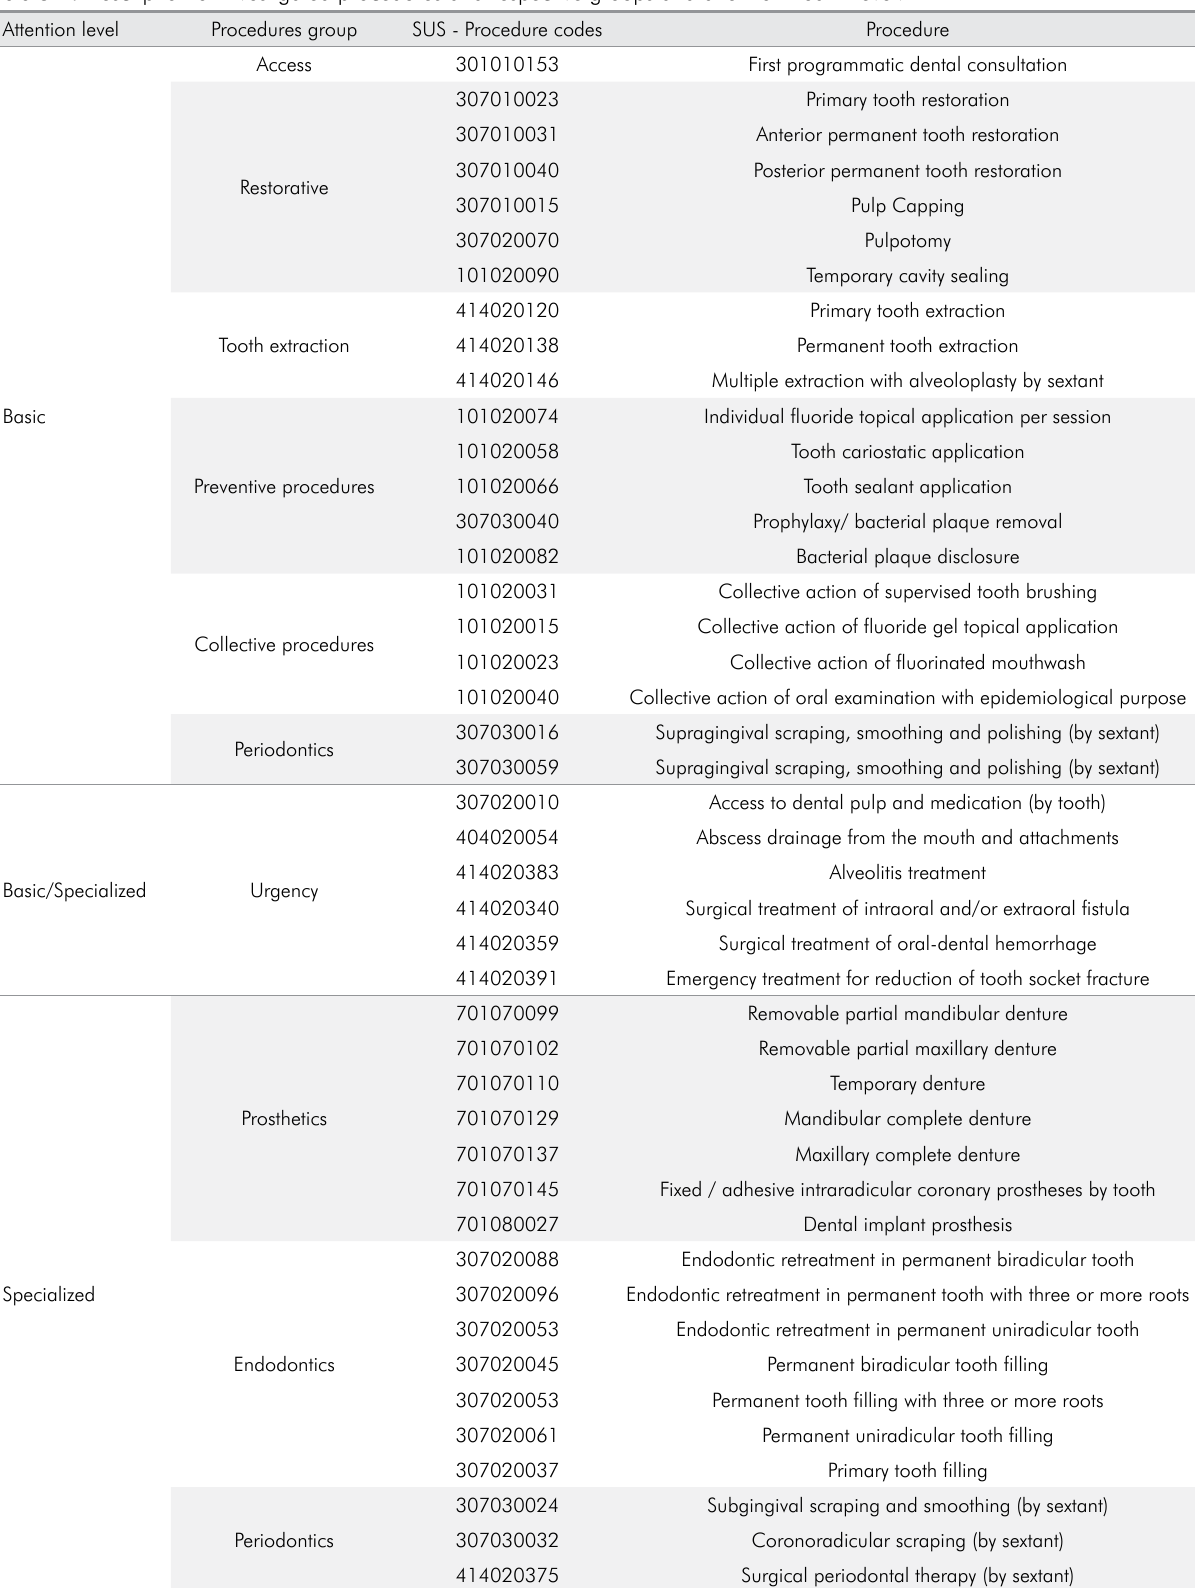
Table 1. Description of investigated procedures and respective groups and attention health level. Attention